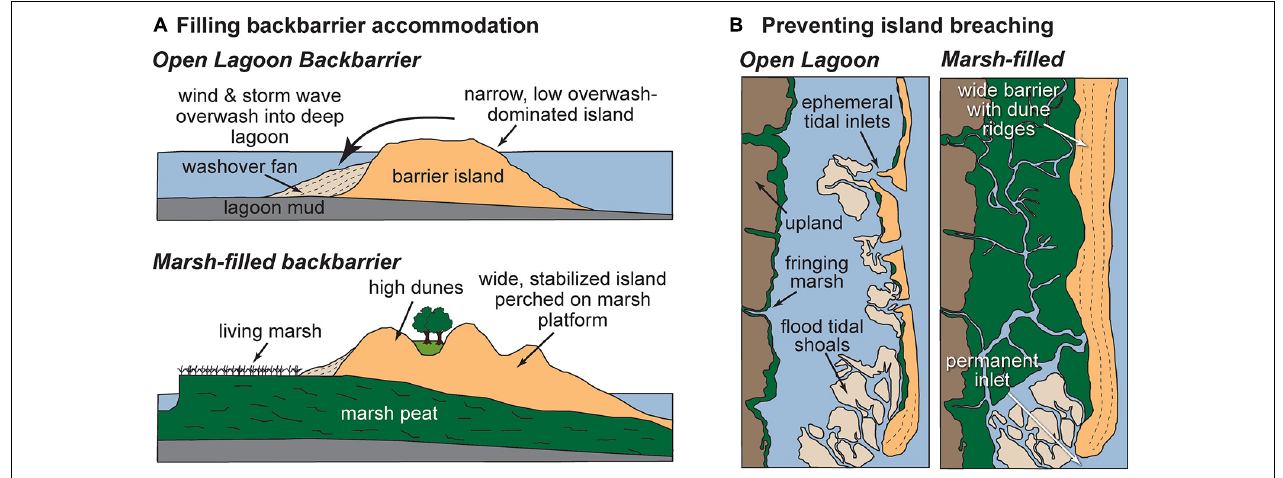
FIGURE 1 | Conceptual model of barrier-saltmarsh couplings along a landward-migrating barrier island. (A) Marsh situated along the landward margins of barrier islands fills backbarrier accommodation, providing a platform upon which the barrier can perch, thereby slowing its migration and allowing sand that would have filled the adjacent lagoon through overwash to build the island vertically. (B) Backbarrier marsh reduces backbarrier tidal prism and widens the barrier-marsh system, reducing the likelihood of breaching and formation of ephemeral tidal